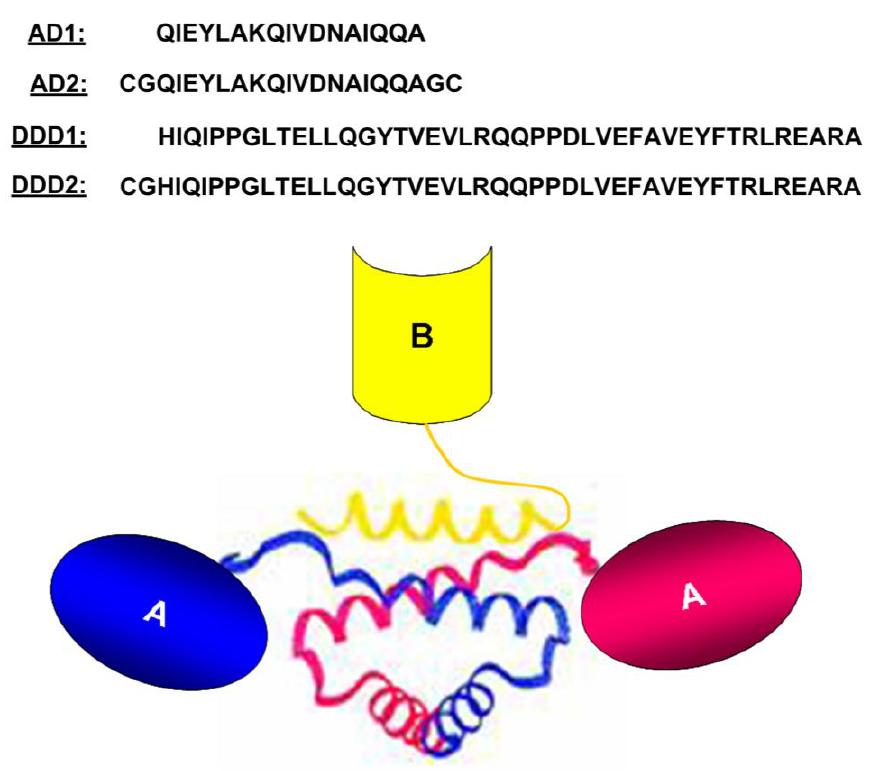
Figure 1. Amino acid sequences (AD1, AD2, DDD1, and DDD2) and a schematic of